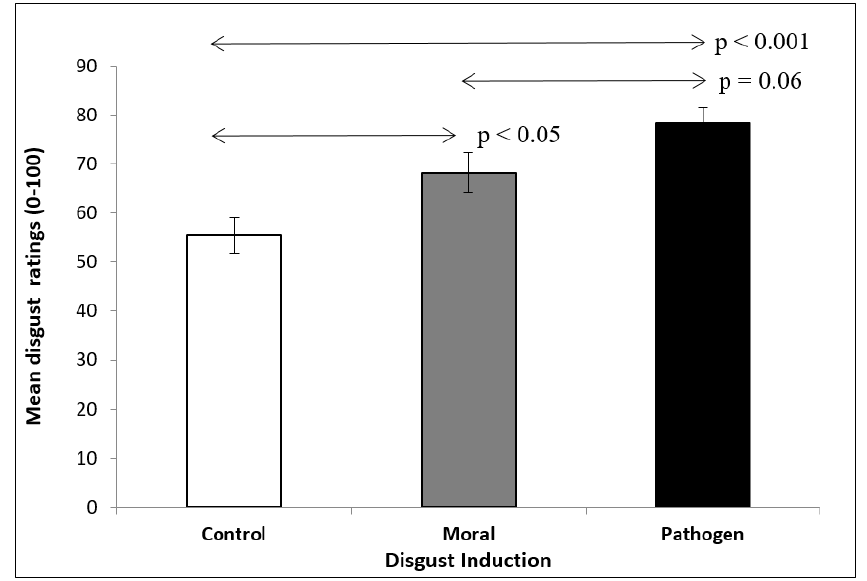
Figure 3. Mean ( ± SE) disgust ratings dependent on disgust induction (Experiment Figure 3. Mean (±SE) disgust ratings dependent on disgust induction (Experiment 2).